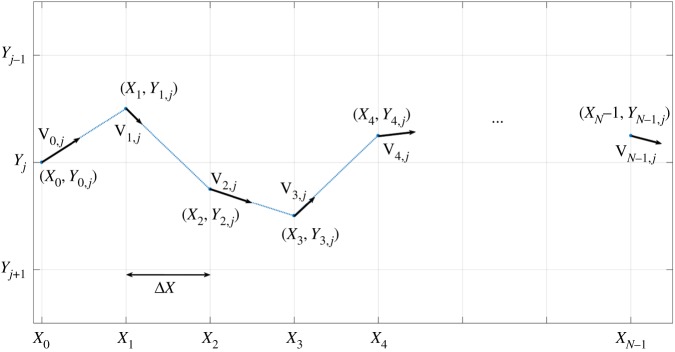
Path generation for each y-axis perturbed pass (ii).